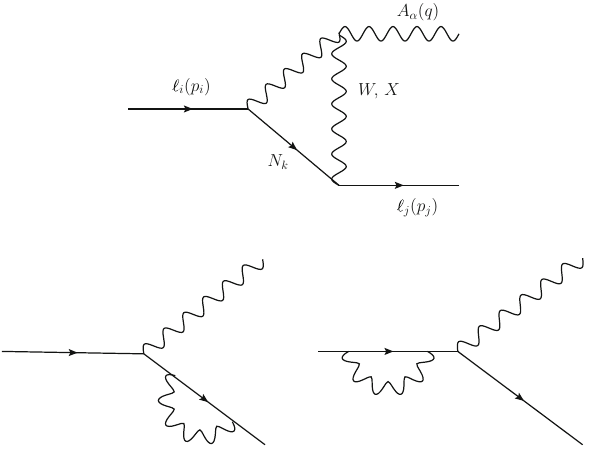
Fig. 3 SLHM contribution to the (cid:6) i → (cid:6) j γ decay at the one-loop level. In the loop circulate the charged W and X gauge bosons and a heavy neutrino N k